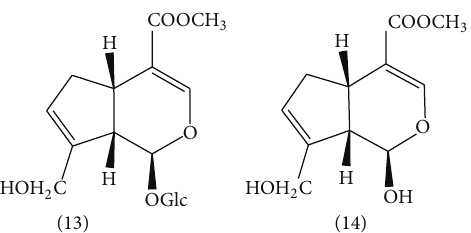
Figure 3: Chemical structure of iridoids: (13) geniposide and (14) genipin.